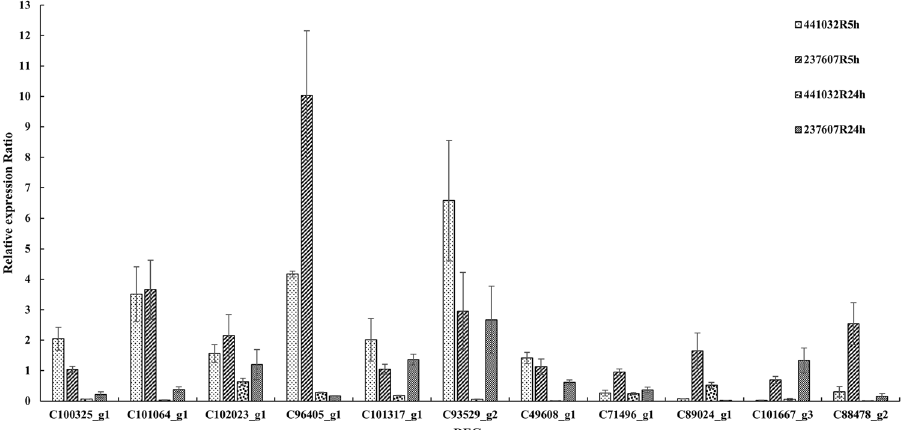
Figure 2. Relative expression of DEGs by qPCR. Mean relative expression ratio with standard deviation was calculated with the data from qPCR with β -actin as reference gene. 4 sets of comparisons were analyzed which were colchicine-treated sample versus water-treated sample of PI 441032 and PI 237607 under 5 h treatment and 24 h